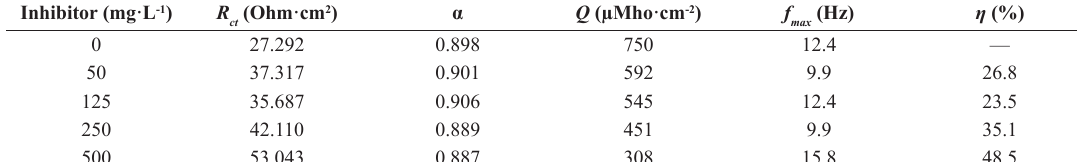
Table 2: Electrochemical parameters obtained from EIS plots for C‑steel in 1.0 mol L -1 H purpurea leaf extract at the following concentrations: 50, 125, 250 and 500 mg·L -1 . Inhibitor (mg·L -1 )